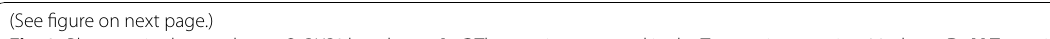
Fig. 2 Phenotypic change due to OsPUB3 knock‑out. A – C Three traits measured in the T 1 experiment using 20 plants. D – M Ten traits measured in the T 2 experiment using a randomized complete block design with three replications. The Duncan’s multiple range test was employed to test the phenotypic differences among the knock‑out mutants, transgenic‑negative control and recipient. Any two groups having a common letter, are not significantly different at a 0.05 level of significance. Instead, any two groups with different letters are significantly different at a 0.05 level